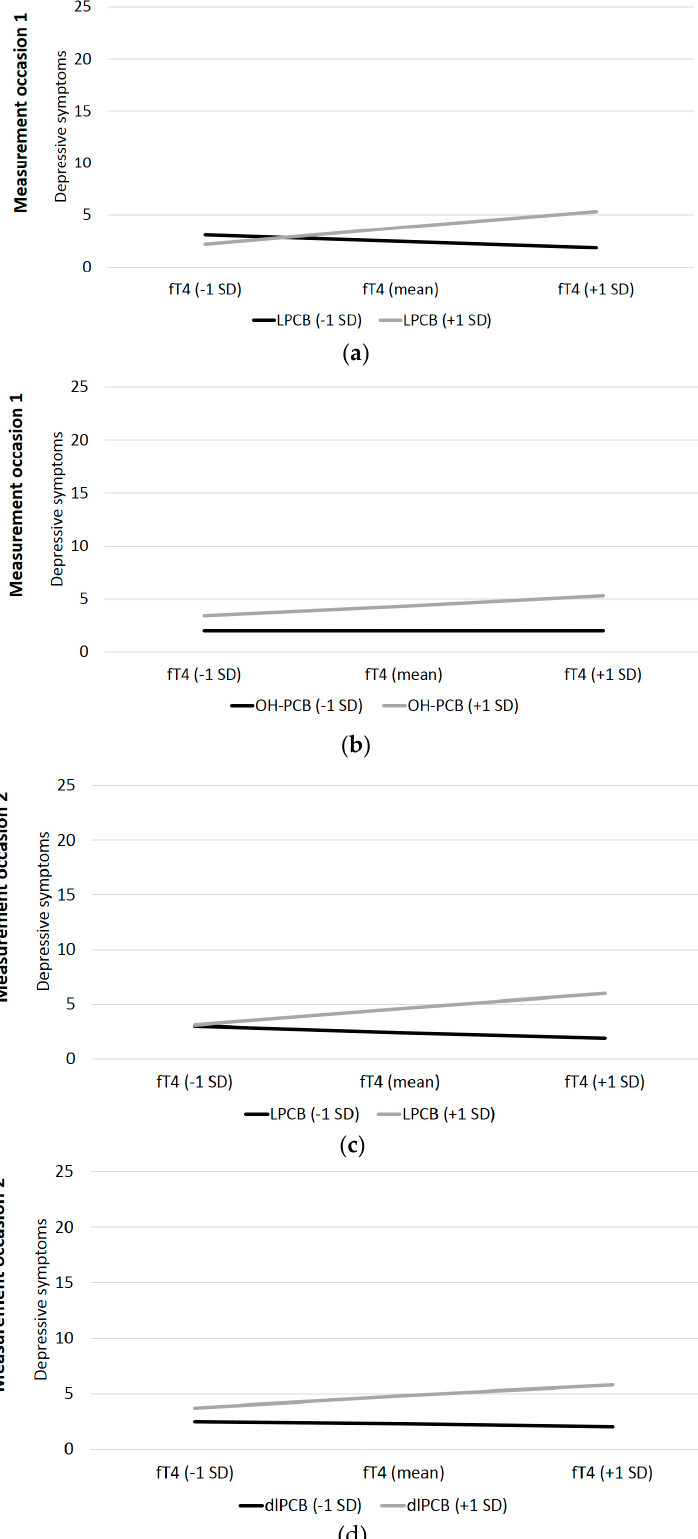
Figure 4. Visualizing the interactions of log transformed and lipid adjusted LPCBs, dlPCBs, and OH-PCBs on the association of fT4 and depressive symptoms; Notes: fT4 = free thyroxine, SD = standard deviation, LPCB = lower chlorinated PCB, dlPCB = dioxin-like PCB, OH-PCB = hydroxylated PCB.